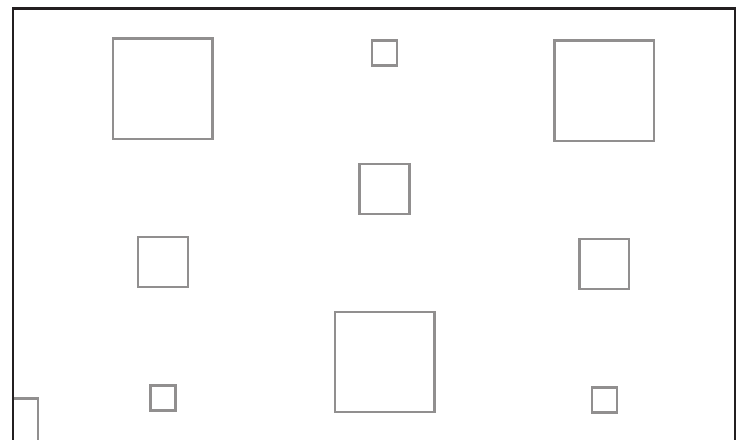
Figure 3: Illustration of defective regions.